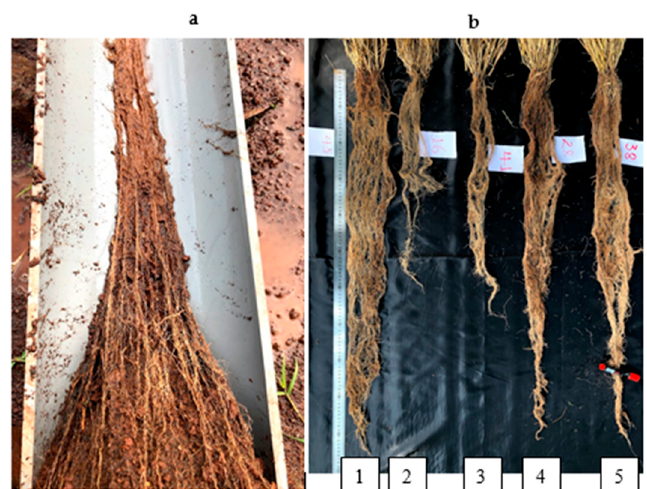
Figure 6. Root systems of selected teff accessions after the PVC experiment. ( a ) Accession 149 during washing. ( b ) Roots of the selected accessions after drying: 1 = 149 (55114-4), 2 = 30 (234431-1), 3 = 116 (204596-2), 4 = 202 (‘Quncho), 5 = 123 (203010-4).